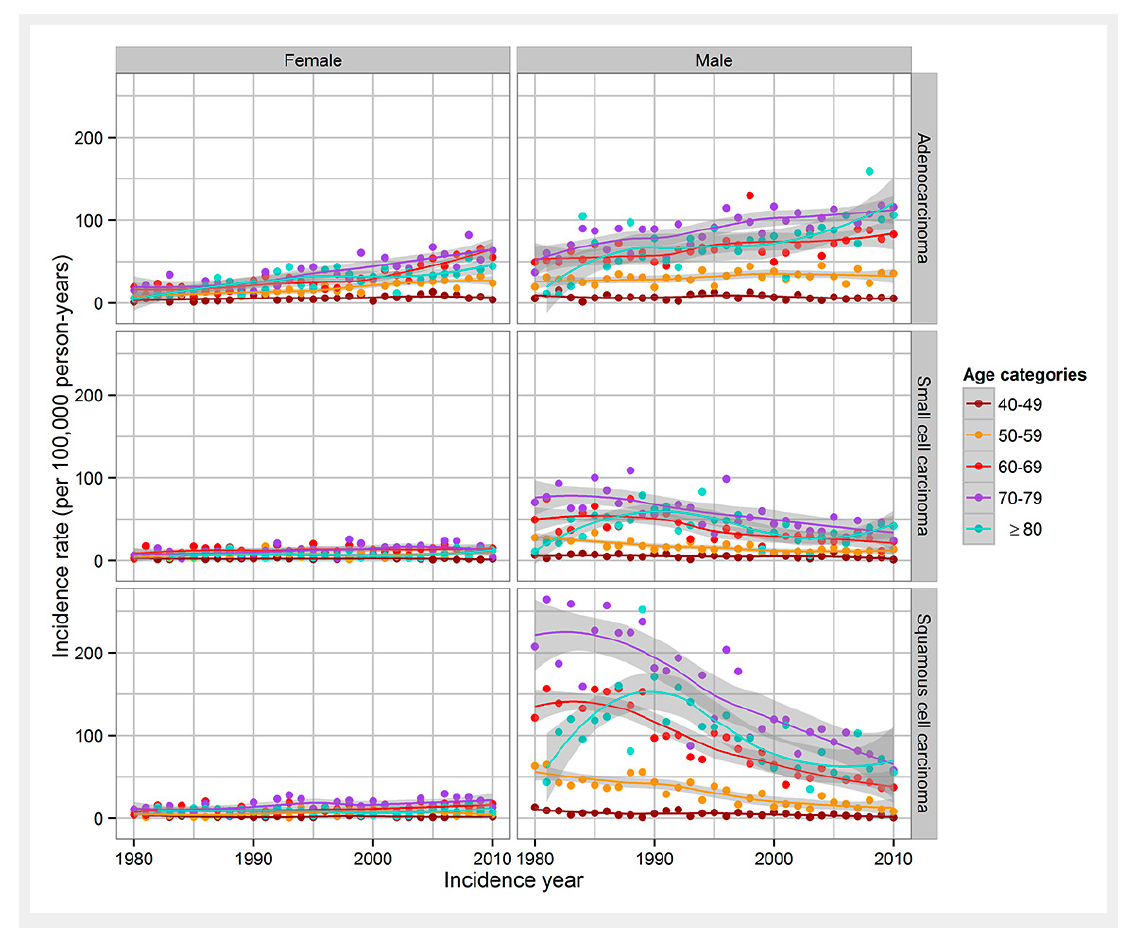
Figure 4 Trends in lung cancer incidence by sex, major histological type and age categories in the Canton of Zurich, Switzerland, 1980–2010. NOS = not otherwise